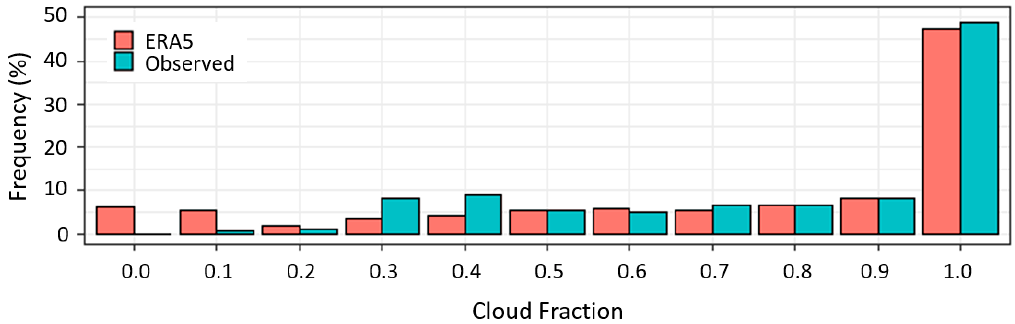
Figure 7. Histogram of cloud fraction for all observations (red) and the corresponding interpolated data from ERA5 (cyan) in 0.1 bins.